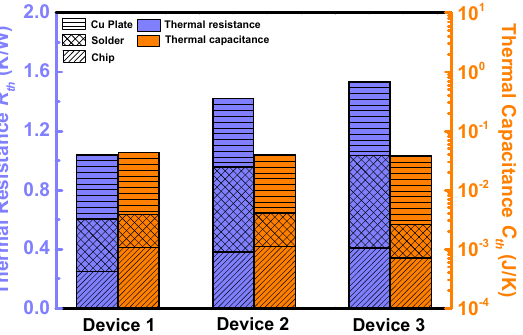
Figure 11. The thermal resistance (left axis) and capacitance (right axis) of each material layer (chip, solder and Cu plate).